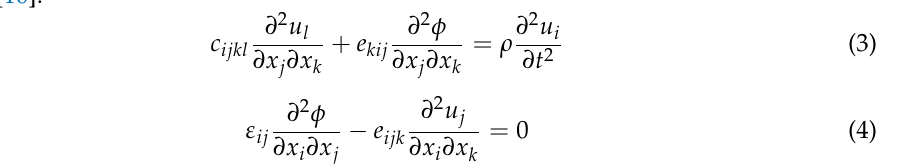
Figure 2. IDT design of the LCRF used in this study. FEM simulation is an essential step in the design and fabrication of SAW devices. The device simulation can not only improve design accuracy, but it can also reduce unneces- sary material losses. In this article, the software used for FEM analysis is COMSOL Mul- tiphysics 5.6, which can easily perform piezoelectric coupling analysis and is used to an- alyze the response of 2D or 3D structural devices to changes in voltage and mechanical load. Thus, this software is suitable for the analysis and simulation of SAW devices. The simulation results can be used as the reference for the design and optimization of future SAW devices [11]. Because the interdigital electrodes of the IDT are periodically distrib- uted, which reduces the simulation time, a simulation model can be established through one cycle. Considering that the Rayleigh wave and its higher-order mode vibrations are mainly limited to one wavelength ( λ ) on the surface, a 2D unit model with a substrate thickness greater than 1.5 λ was established, as shown in Figure 3. In Figure 3a, p is the distance between two adjacent metal electrodes; a is the width of the metal electrode; and ℎ (cid:2869) , ℎ (cid:2870) , ℎ (cid:2871) , ℎ (cid:2872) , and ℎ (cid:2873) indicate the thicknesses of the lithium niobate, diamond, silicon, metal, and SiO 2 layers, respectively. To eliminate the influence of the metallization rate and obtain the maximum reflectivity of the reflector, the metalli- zation rate ( MR = a/p ) was designed to be 0.5. After the metallization rate was determined, because the propagation characteristics of the layered SAW structure are independent of the wavelength, the SAW wavelength was designed to be λ = 6 μ m. Because most of the energy of the SAW is confined to the surface, and the thicknesses ℎ (cid:2870) and ℎ (cid:2871) are ex- cluded, it was set to a fixed value while ℎ (cid:2869) , ℎ (cid:2872) , and ℎ (cid:2873) were designed as variables. An aluminum electrode with a wavelength of 6 μ m was deposited on the LiNbO 3 surface. Silicon is assumed to be a semi-infinite substrate. The film thickness ratios ℎ (cid:2869) /𝑎 and ℎ (cid:2873) /𝑎 had ten values in the range of 0.1 to 1 with the interval of 0.1, and ℎ (cid:2872) /𝑎 had five values in the range of 0.1 to 0.5, with the interval of 0.1. A perfectly matched layer (PML) can absorb propagating waves, accelerate the attenuation of evanescent waves, and per- fectly match arbitrary lossy media [12]; therefore, a PML of 1 λ was set in this study. In COMSOL, the model needs to be meshed. As shown in Figure 3b, to ensure calculation accuracy, we divided the minimum free quadrilateral unit, the smallest unit being 1.26 nm. For the IDT structure, N G , N IN , and N OUT indicate the number of reflective gratings, input fork index, and output fork index, respectively. The specific geometric parameters involved are shown in Table 1.